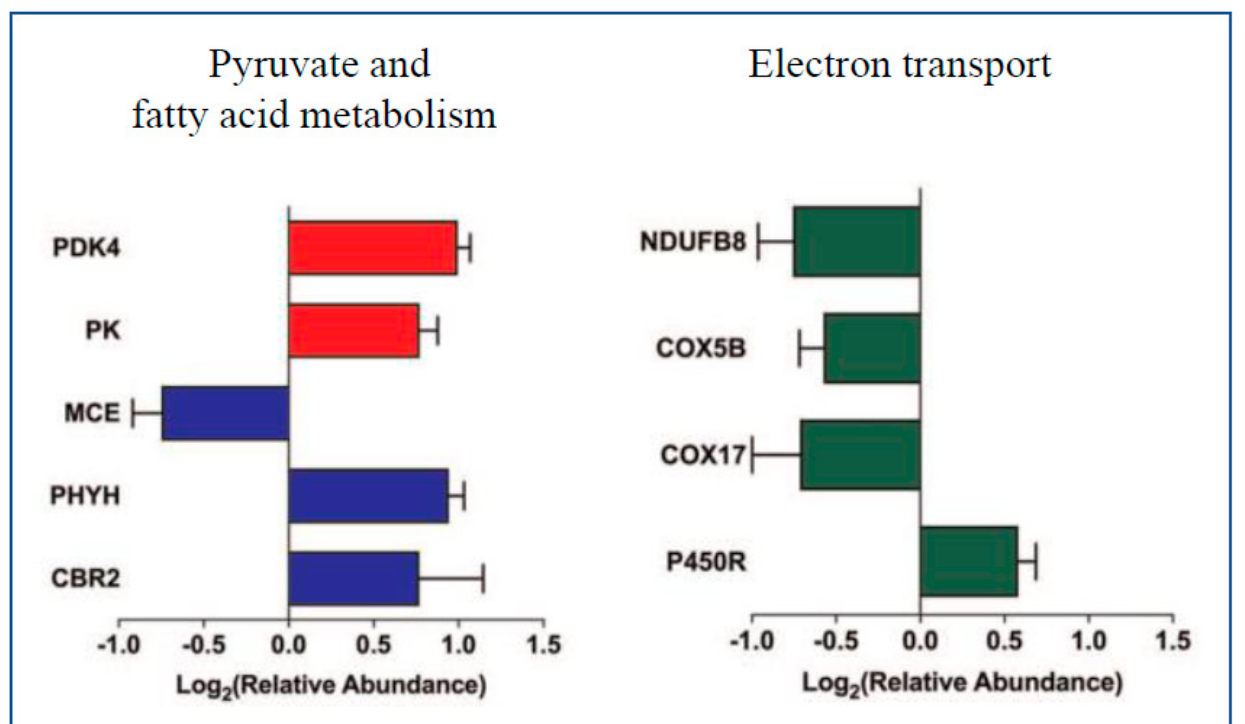
Figure 3. The mitochondrial proteins of isolated cardiac mitochondria from septic (CLP) mice involved in pyruvate metabolism (red), fatty acid metabolism (blue) and electron transfer (green) with altered expression. CLP—cecal ligation and puncture; Log2—logarithm of expression ratios between CLP and sham mice for the proteins with p -values < 0.05; PDK4—pyruvate dehydrogenase kinase 4, PK—pyruvate kinase, MCE—methylmalonyl-CoA epimerase, PHYH—phytanoyl-CoA dioxygenase, CBR2—carbonyl reductase (NADPH) 2, NDUFB8—NADH dehydrogenase (ubiquinone) 1 beta subcomplex subunit 8, COX5B—cytochrome c oxidase 5B, COX17—cytochrome